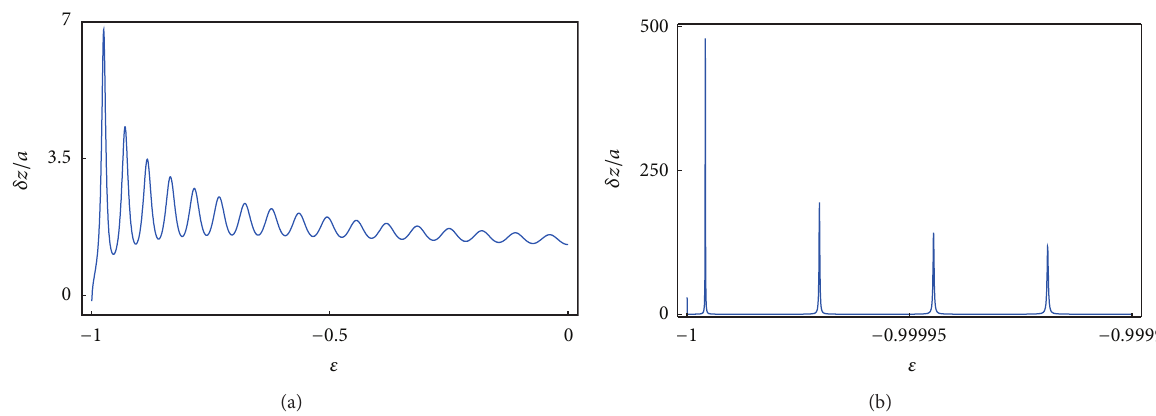
Figure 2: Longitudinal shift as a function of the propagation constant 𝜀 = −𝑝 𝑧 for a dielectric slab of width 𝑘 0 𝑎 equal to (a) 30 and (b) 5×10 4 . In both cases 𝑈 0 = 1.5 .